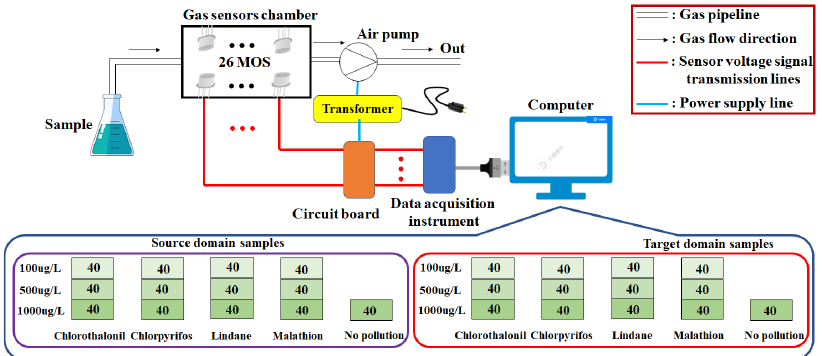
Figure 3. The flow chart of sample detection by e-nose. The transformer converted 220 V voltage into 5 V voltage to serve as an electric power supply device for the air pump and conditioning circuit on the circuit board. The data acquisition instrument was connected to the computer via USB to obtain electric power. The air pump served as a power source to transport the gas emitted from the sample to the gas sensors chamber. In the chamber, the gas would react with the sensor material at the surface, causing the sensor resistance to change, which in turn led to the output voltage of the conditioning circuit changing. The output voltages were read and converted into digital signals by the data acquisition instrument. The digital signals were stored in the computer. The data in the figure represented the type and number of the detection samples in this